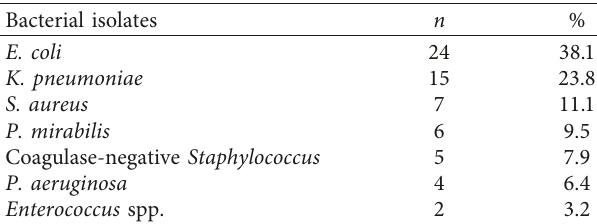
Table 2: Frequency of bacteria isolates among HIV-positive